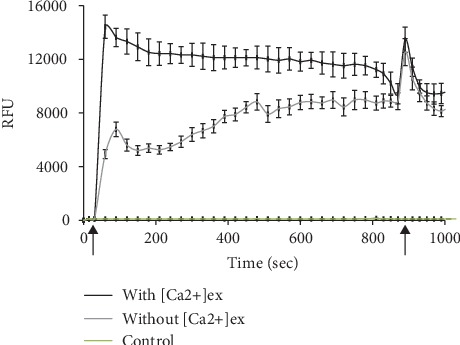
Sources of compound 4-mediated [Ca2+]i signals in SH-SY5Y cells. The cells were stimulated with 100 μM compound 4 in the presence or absence of extracellular Ca2+ ions in medium. Typical traces of [Ca2+]i responses in the presence (black) or absence (grey) of 1 mM Ca2+. The first arrow indicates the time of compound 4 addition. Subsequent addition of 1 mM Ca2+ as indicated (the second arrow) 870 s after stimulation with compound 4. Control is RFU level in Fura-4 NW loaded cells without stimulator. Values were presented in RFU (relative fluorescence values/relative fluorescence units) ± SD.